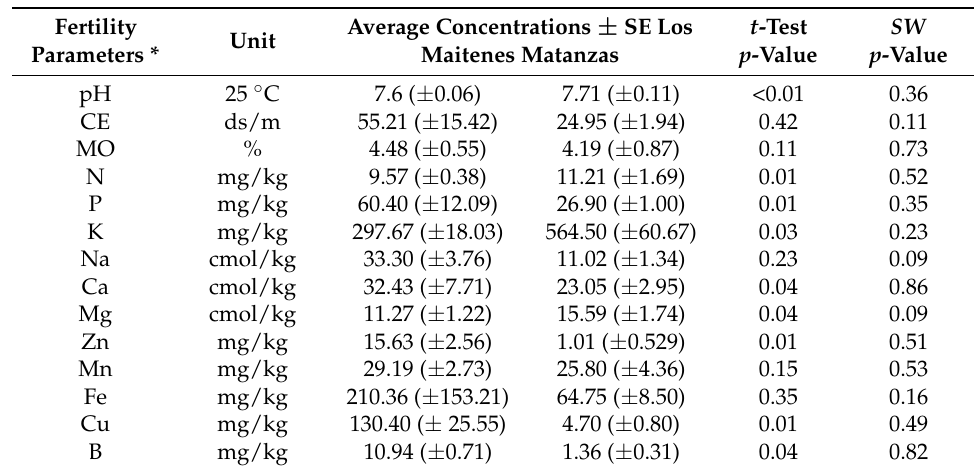
Table 2. Exploratory data analysis for the fertility parameters.